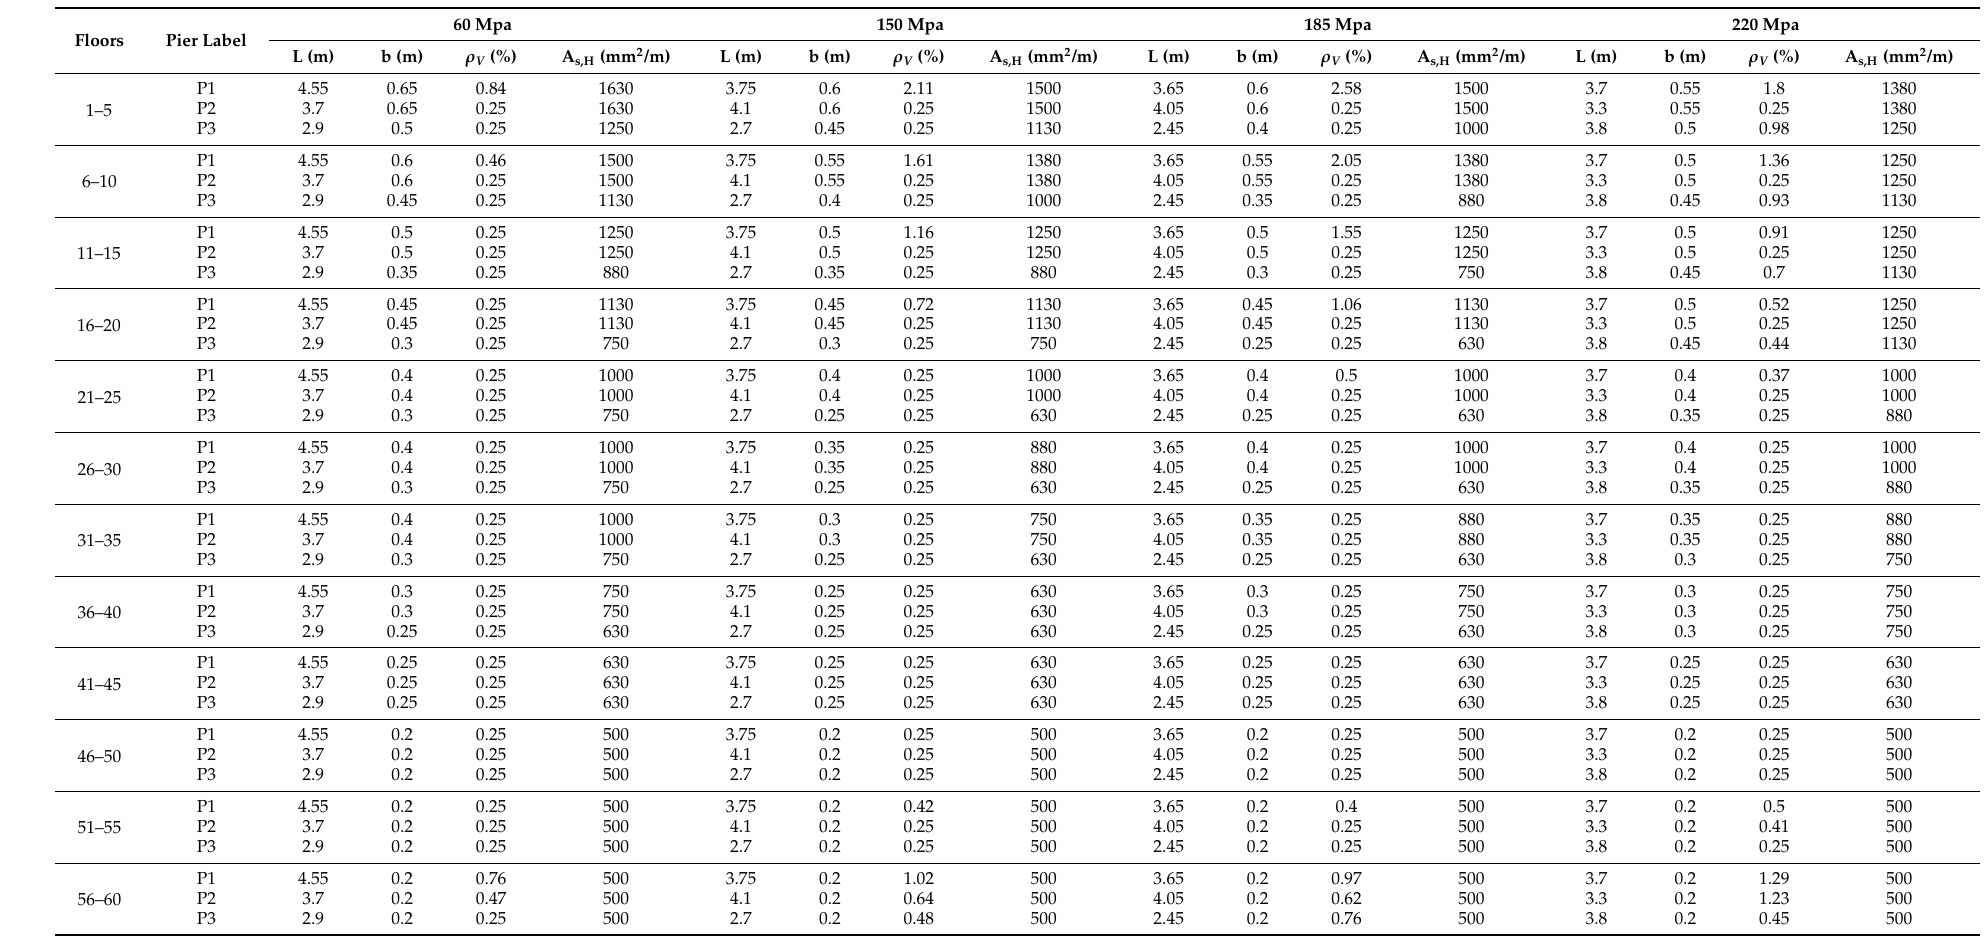
Table 4. Shear walls design